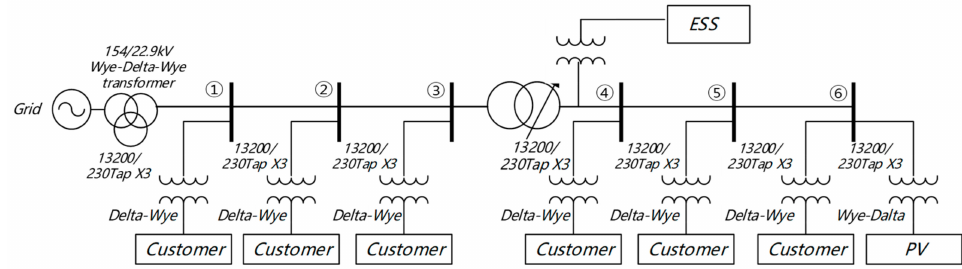
Figure 14. Voltage control algorithm by SVR and